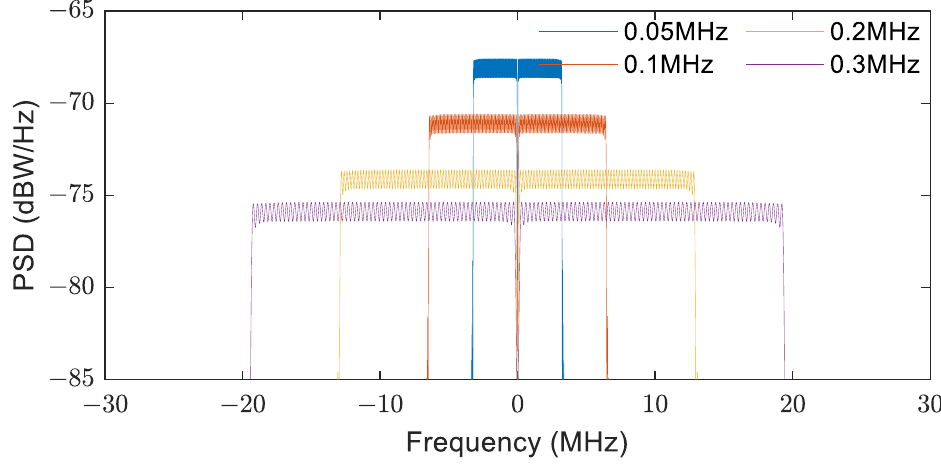
Figure 6. The PSD with different subcarrier intervals.